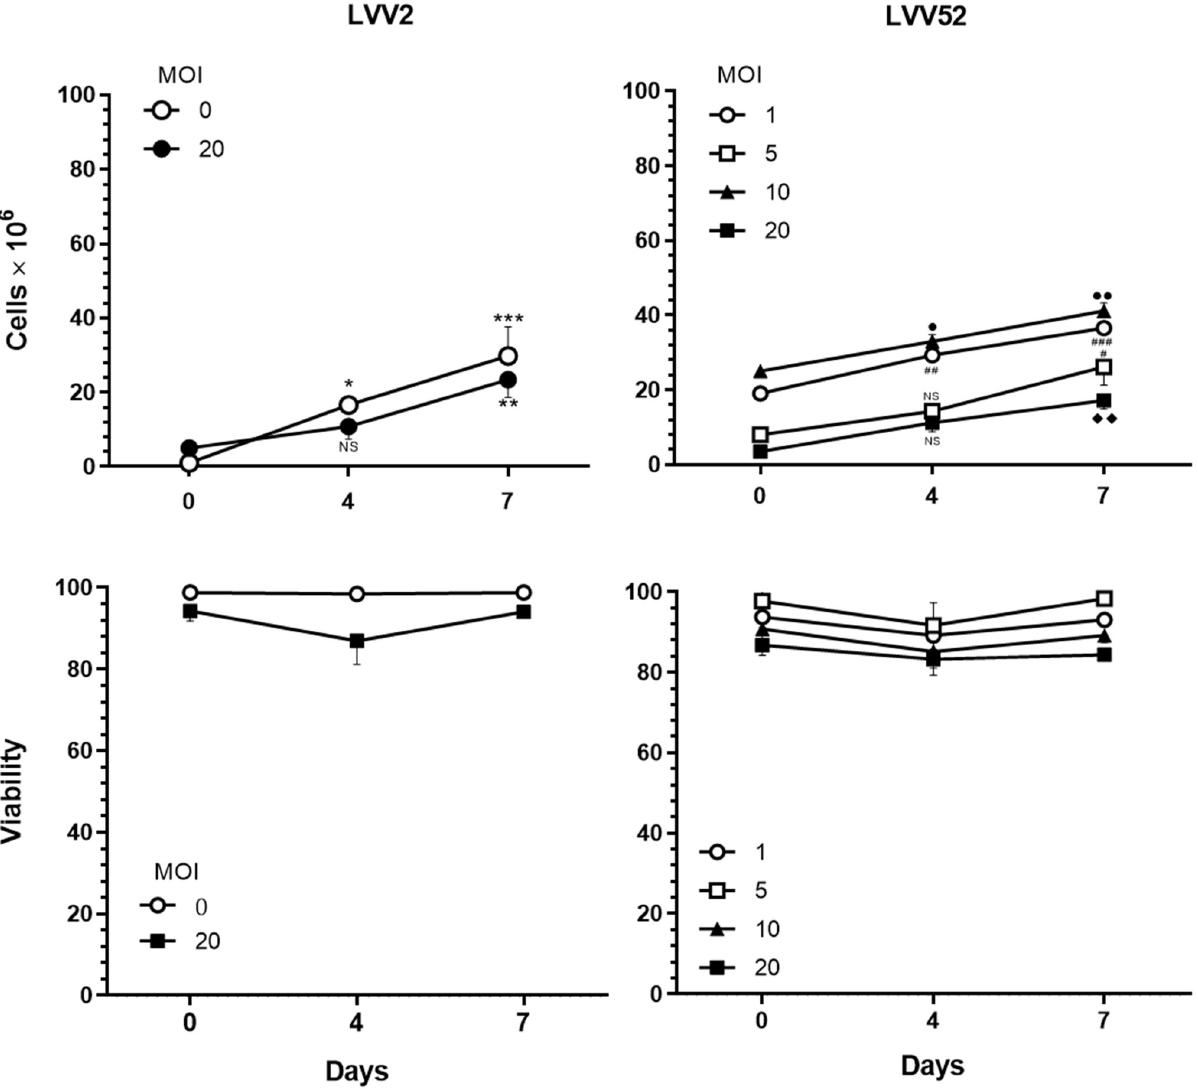
Fig 1. Cell expansion and viability of PBMC following transduction with LV52. PBMCs from 3 donors were transduced with the LVV2 (left panels) or LV52 (right panels) using the indicated MOIs. The upper panels showed the total cells recovered, and the lower panels showed the viability of the cultures at the indicated time points. The data shown are the mean ± SEM of 3 independent experiments. � p = 0.0122, �� p = 0.0016, ��� p = 0.0001, # p = 0.0177, ## p = 0.0052, ### p = 0.0003, ● p = 0.0477, ●● p = 0.0015, ◆◆ p = 0.0072; one-way ANOVA.